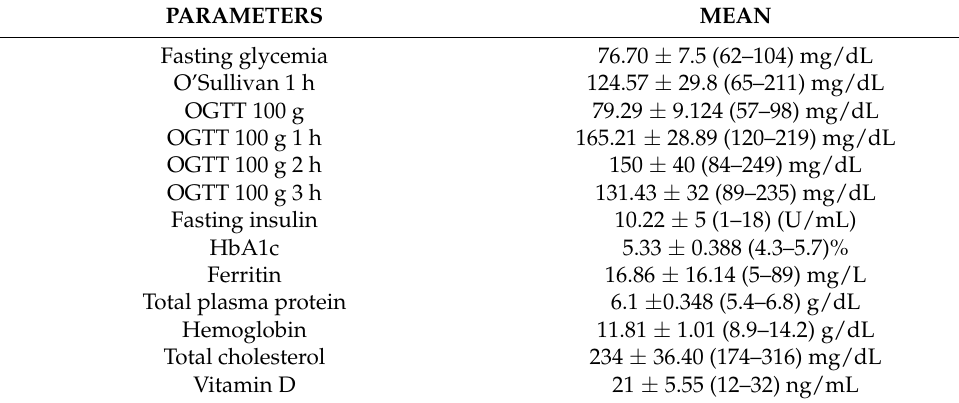
Table A4. Biochemical results.